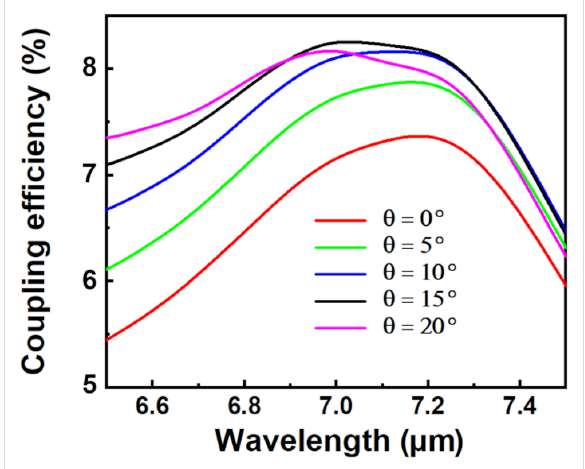
Figure 2: Coupling efficiency of the MIR FGC at different incident angles when R = 7.15 μ m, r = 6.15 μ m, d = 3.55 μ m, and α = 120°.